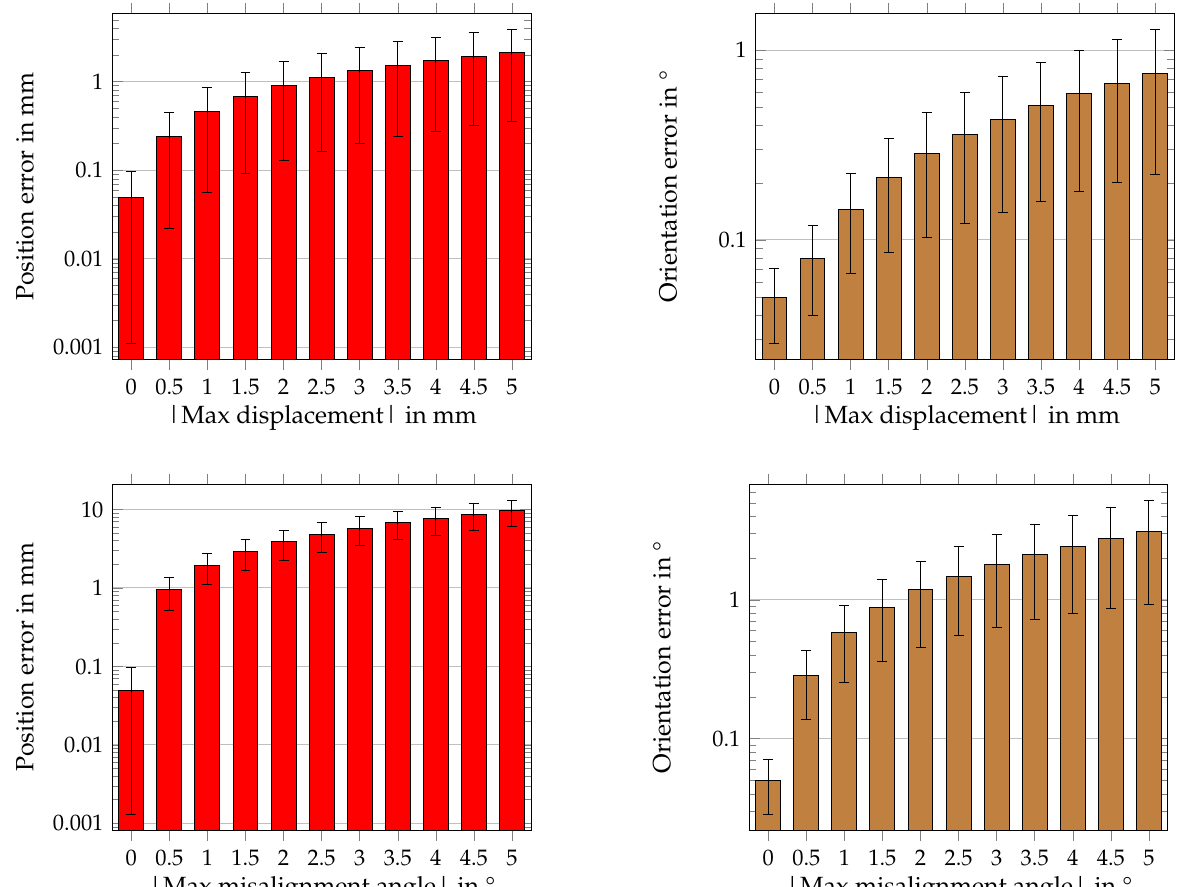
Figure 10. Mean position and orientation errors for different maximal random displacement and misalignment of sensors. The y -axis is in log-scale.